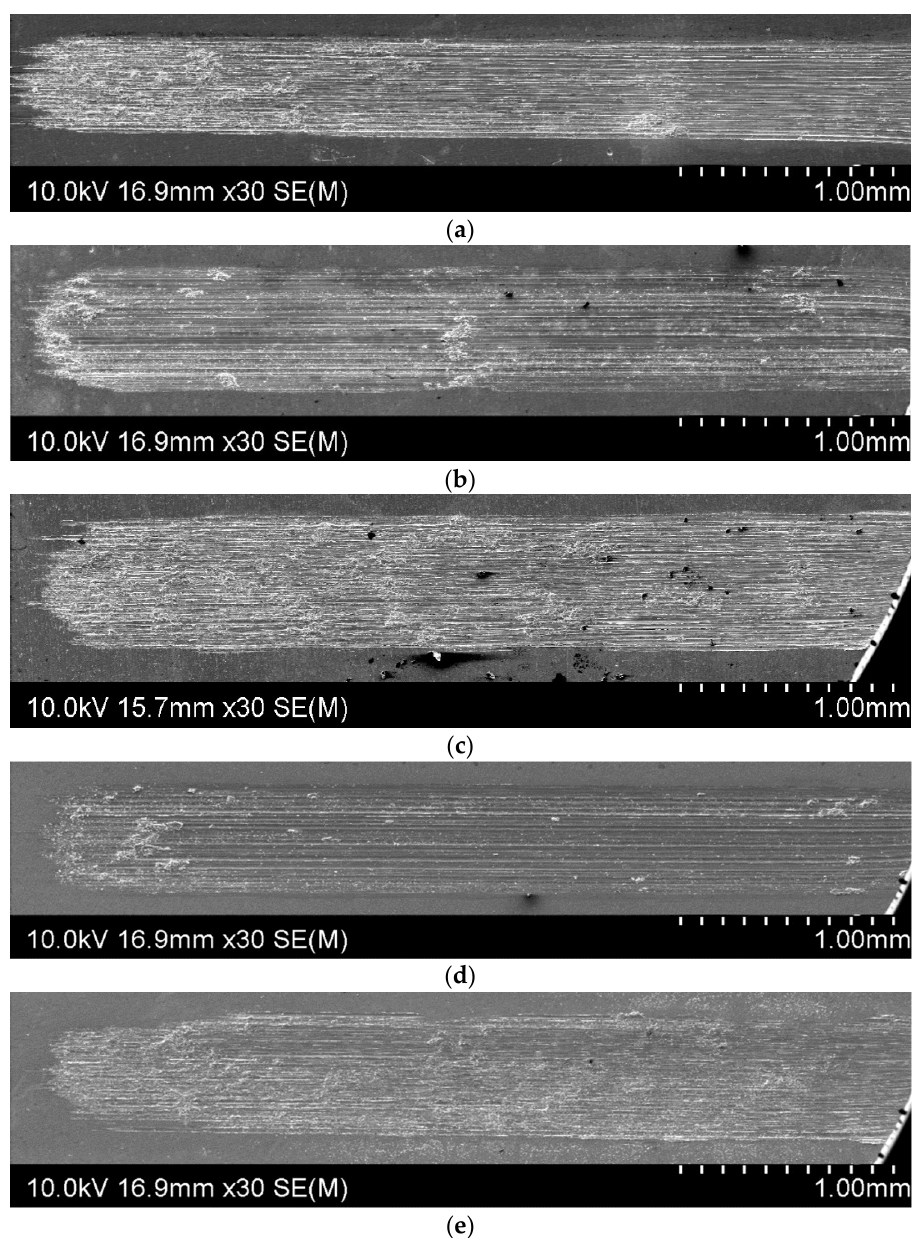
Figure 6. SEM images of wear tracks of ( a ) CP N1, ( b ) SLM N2, ( c ) CP N2, ( d ) SLM non-treated, and ( e ) CP non-treated samples, after the first respective wear experiment.